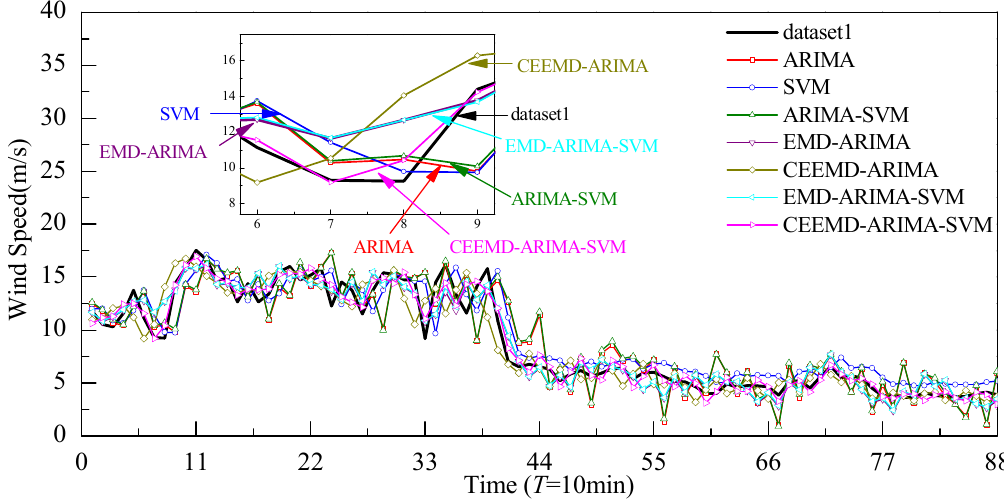
Figure 5. SVM prediction results.